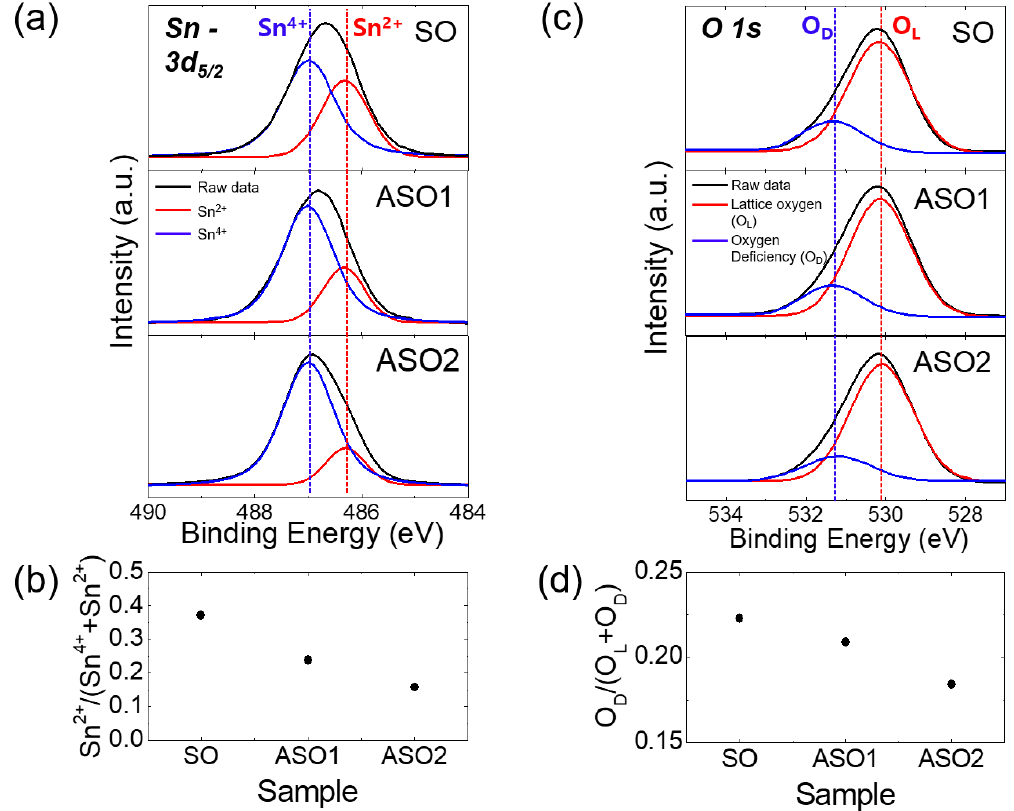
Figure 3. ( a ) Sn 3d 5/2 X ‐ ray photoemission spectroscopy (XPS) spectra of SO, ASO1, and ASO2 thin ‐ films. ( b ) Relative peak intensities [Sn 2+ /Sn 4+ + Sn 2+ ] of the Sn 2+ peaks. ( c ) O 1s XPS spectra of SO, ASO1,